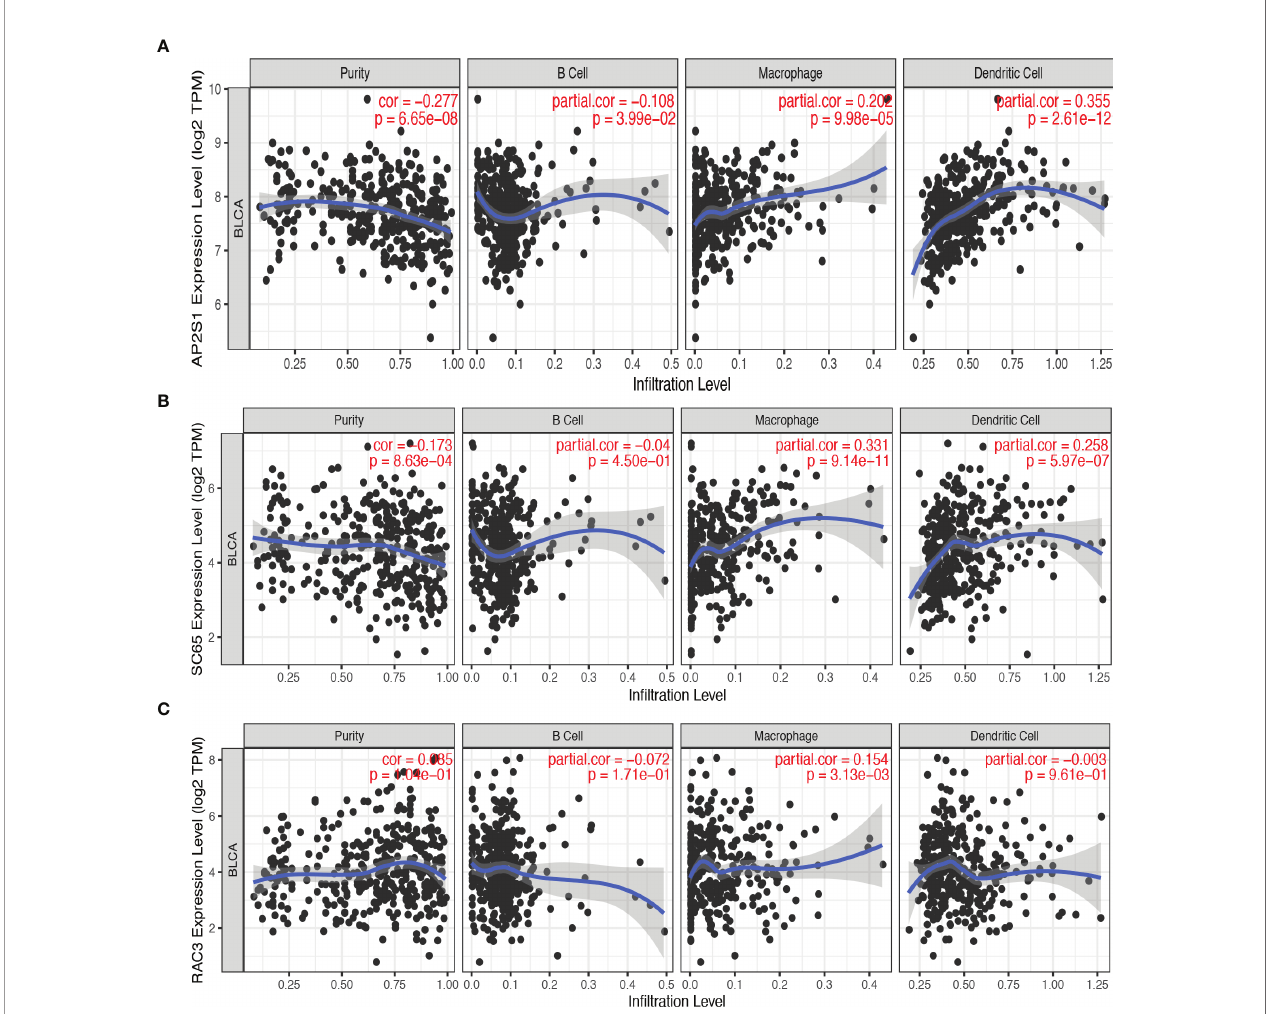
FIGURE 3 | The correlation between candidate tumor antigens and antigen-presenting cells. (A) Association of AP2S1 expression with the purity of in fi ltrating cells and the number of macrophages, dendritic cells, and B cells in BLCA. (B) Association of P3H4 ( SC65 ) expression with the purity of in fi ltrating cells and the number of macrophages, dendritic cells, and B cells in BLCA. (C) Association of RAC3 expression with the purity of in fi ltrating cells and the number of macrophages, dendritic cells, and B cells in